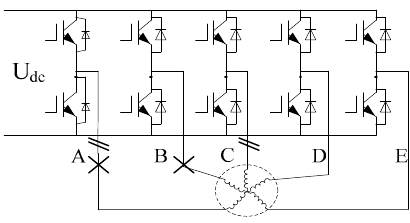
Figure 3. Two-phase open fault of FPMSM.